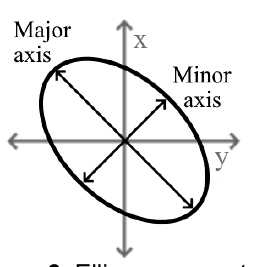
Figure 6. Ellipse parameters